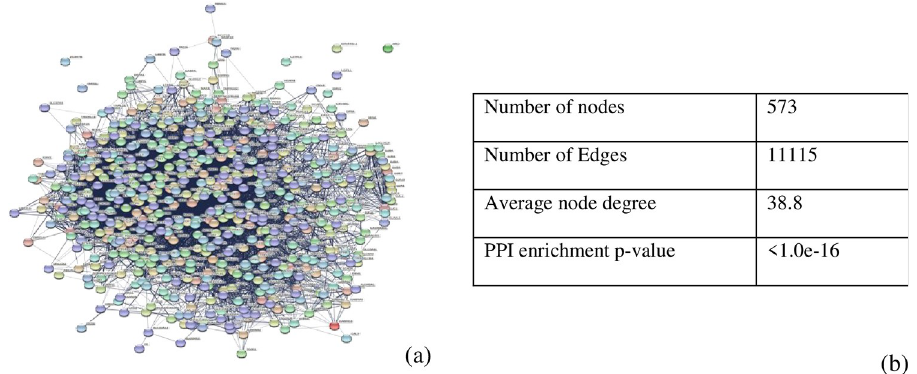
Fig 2. Construction of PPI network using STRING database. (a) PPI Network of Total Target Genes. (b) Network Stats of the obtained result.